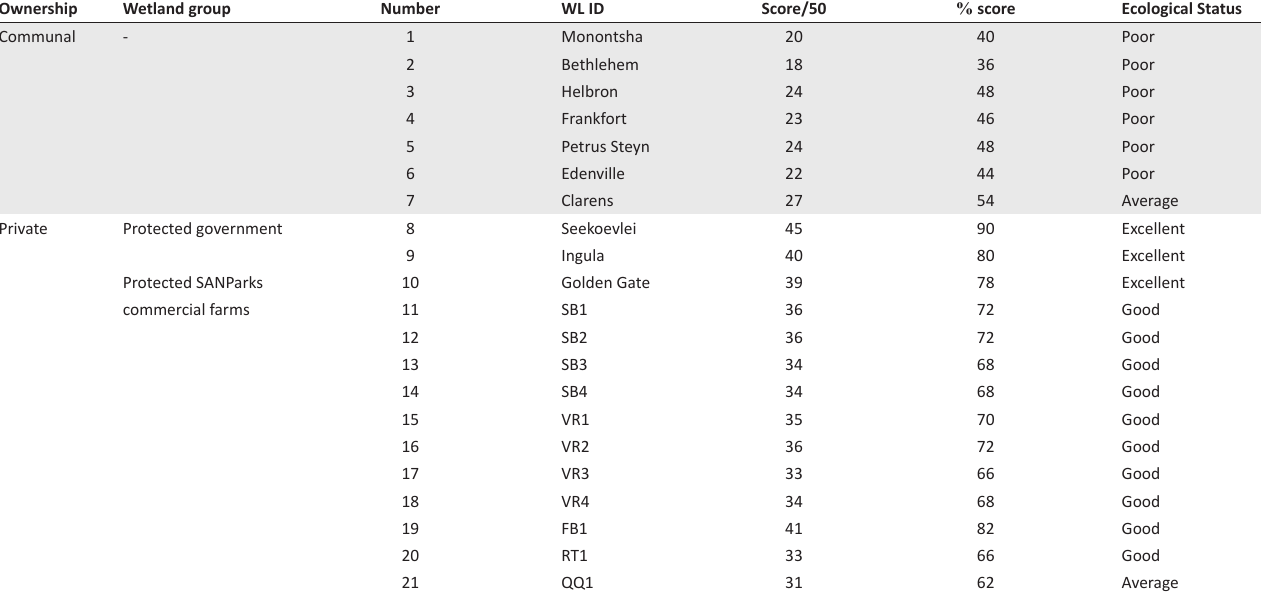
TABLE 6: Ecological status of valley-bottom wetlands from field observation. Ownership Wetland